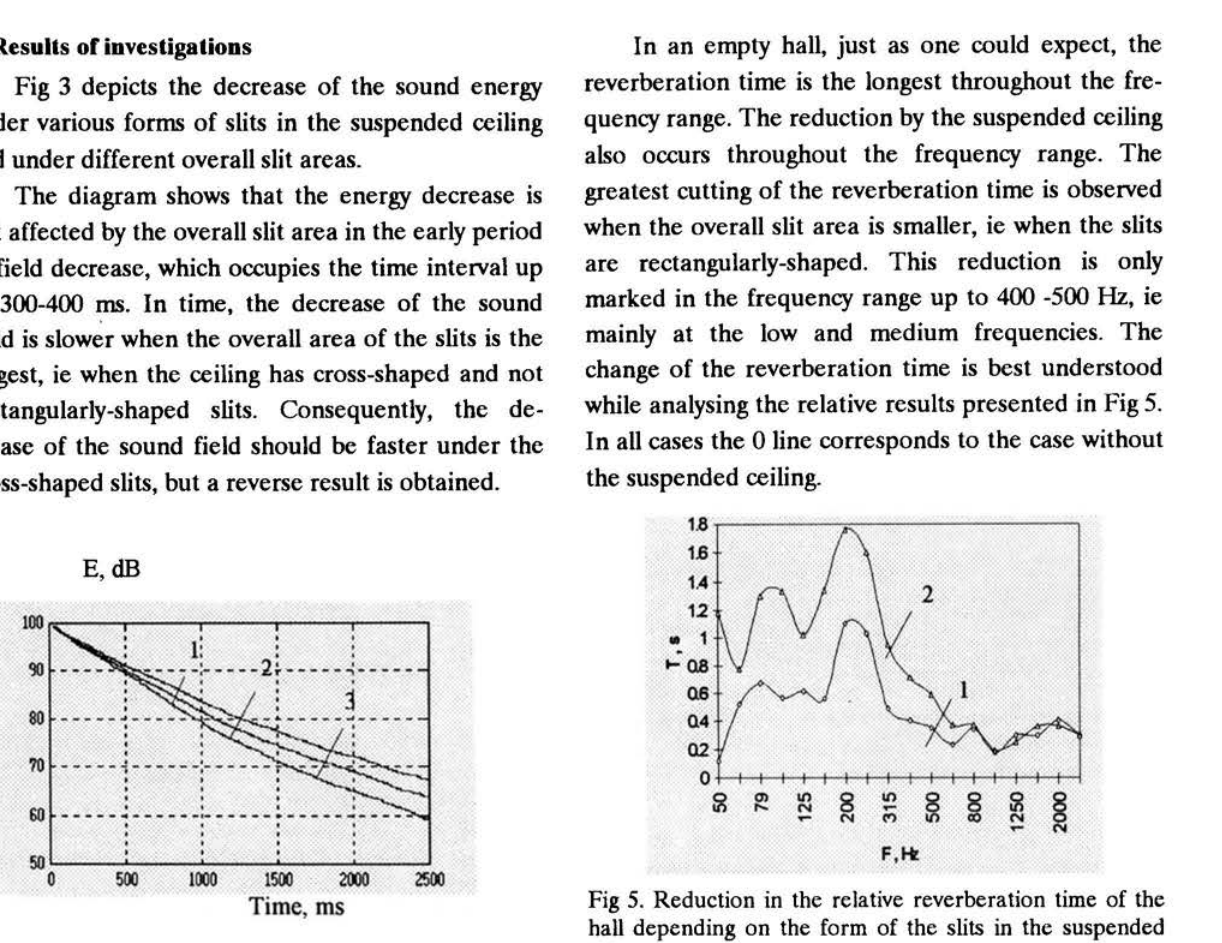
Fig 5. Reduction in the relative reverberation time of the hall depending on the form of the slits in the suspended ceiling and the overall slit area. 1 - cross-shaped slits; 2- rectangularly-shaped